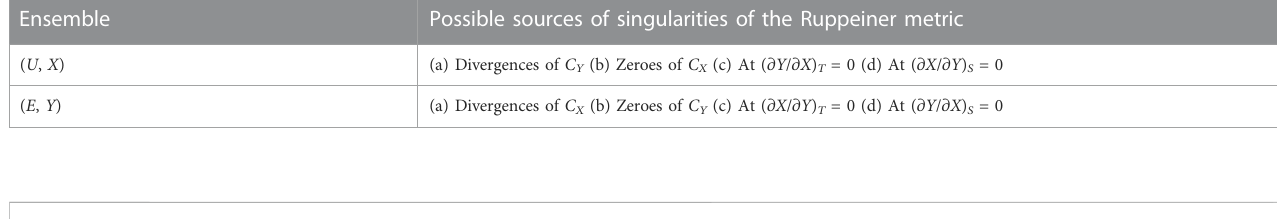
TABLE 1 Possible sources of singularities of the Ruppeiner metric. Ensemble Possible sources of singularities of the Ruppeiner metric